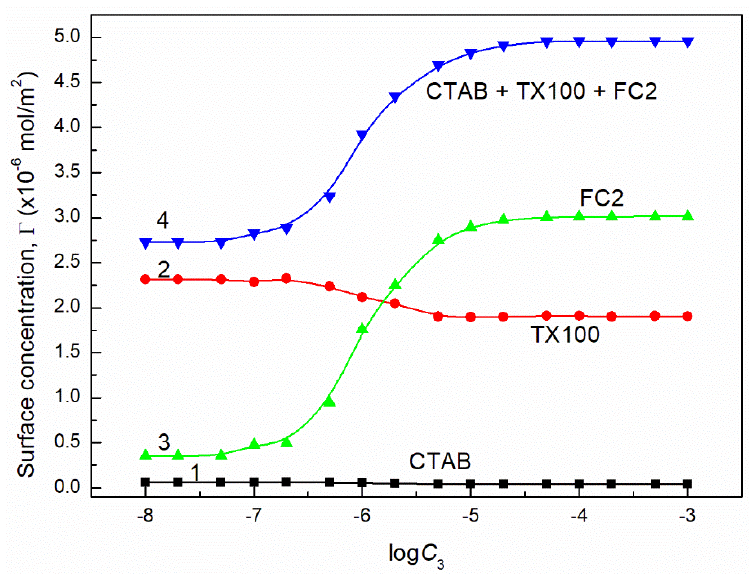
Figure 17. A plot of the concentration of CTAB (curve 1), TX100 (curve 2), FC2 (curve 3) and their sum (curve 4) in the mixed monolayer at the water-air interface formed by the CTAB + TX100 + FC1 mixture at the constant concentration of the binary CTAB + TX100 mixture ( C 12 ) and γ LV = 60 mN/m as well as calculated from Equation (12) based on the contribution of the given surfactant to the reduction of water surface tension vs. the logarithm of the FC2 concentration ( logC 3 ).